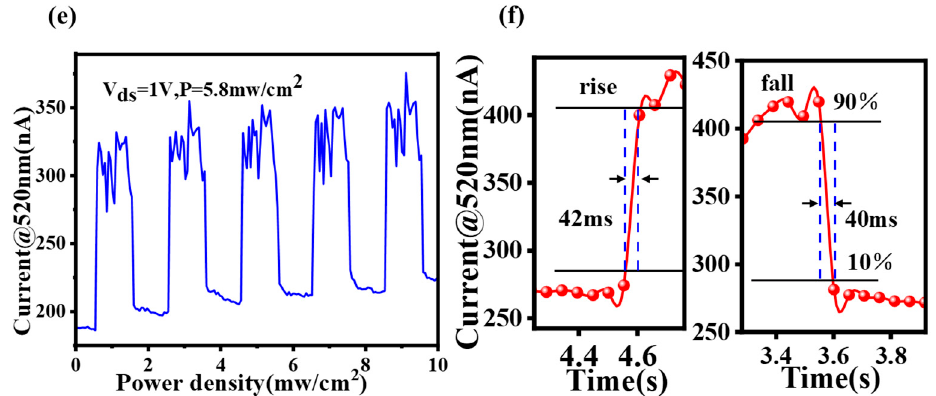
Figure 7. ( a ) Schematic illustration of the heterostructure photodetector; ( b ) I ds -V ds curves of the heterostructure photodetector at V g = 0 V and V ds = 0 V with different laser powers; ( c ) photocurrent vs. power density of the MWCNT-MoS 2 heterostructure photodetector device at V g = 0 V and V ds = 1 V; ( d ) variation in detection rate and responsiveness at different optical power densities; ( e ) variation in device response time at V ds = 1 V with an incident power of 5.8 mW/cm 2 illumination; ( f ) time-resolved photoresponse, where the rise and fall times of the photocurrent are 42 ms and 40 ms, respectively.